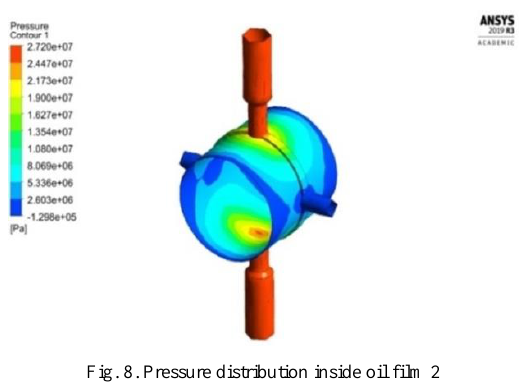
Fig. 8. Pressure distribution inside oil film 2